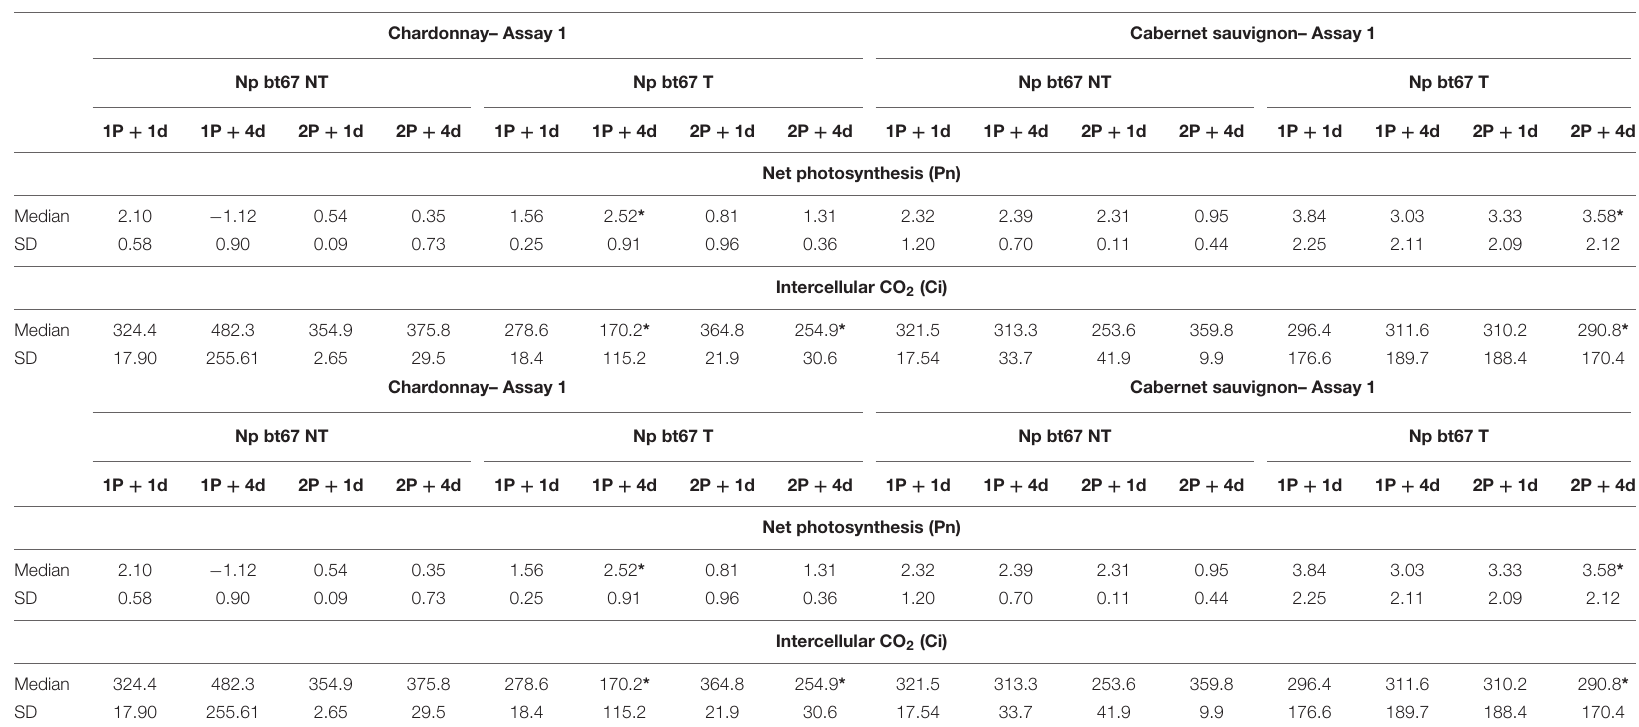
Data are the medians of three values ± SD. The asterisk (*) indicates a significant difference (Mann-Whitney U test, p < 0.05) between treated (T) and non-treated (NT) conditions at the same kinetic point. 1P = first post infection treatment; 2P = second post infection